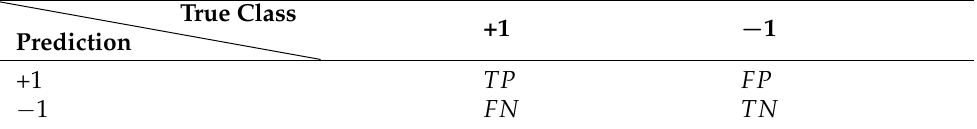
Table 3. Confusion matrix built for the binary classification problem under